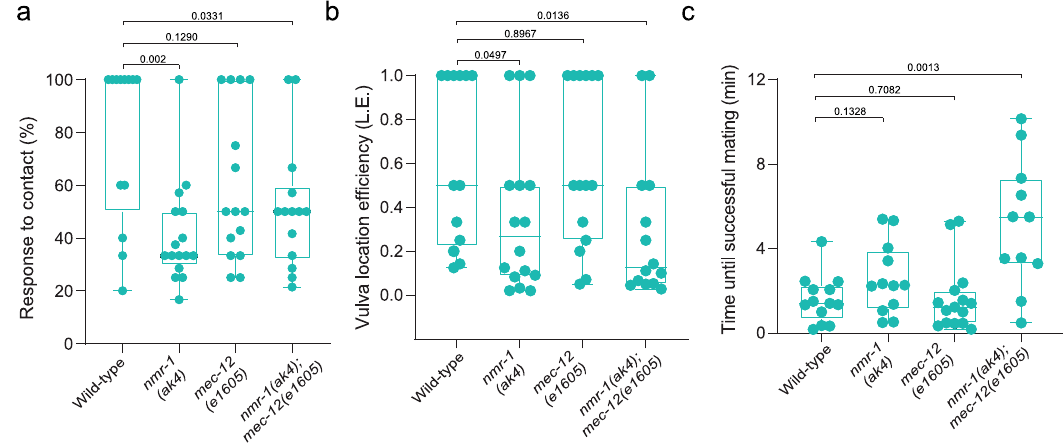
Fig.7| nmr-1 and mec-12 functioninthemalematingbehavior.a Quanti fi cation of response to contact in wild-type ( n =13) nmr-1(ak4) ( n =16), mec-12(e1605) ( n =15) and nmr-1(ak4);mec-12(e1605) ( n =14) males. b Quanti fi cation of vulva locationef fi ciency(L.E.,seeMethods)inwild-type( n =13) nmr-1(ak4) ( n =16), mec- 12(e1605) ( n =15) and nmr-1(ak4);mec-12(e1605) ( n =14) males. c Quanti fi cation of